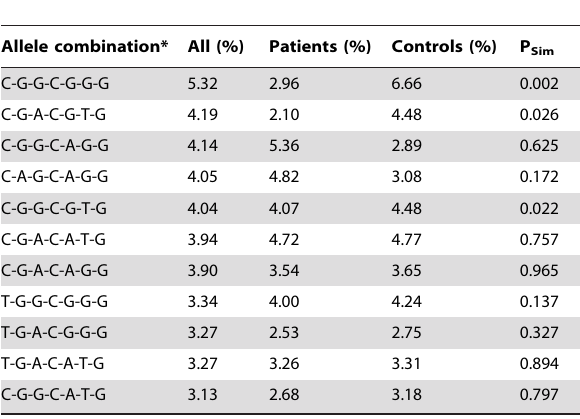
Table 3. The allele combinations of seven polymorphisms under study between breast cancer patients and controls.